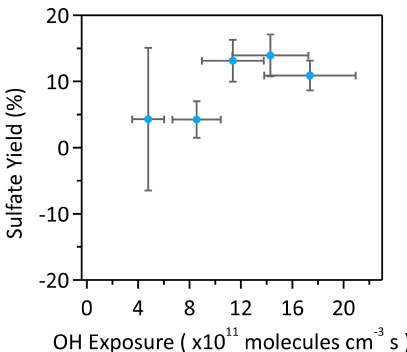
Figure 5. Molar yields of inorganic sulfur species (HSO 4 − and SO 42 − ) as a function of OH exposure upon heterogeneous OH ox- idation of α pOS-249. The x -error bars represent the uncertainties for OH exposures and y -error bars represent the uncertainties of derived molar yields (calculation details can be referred to the Sup-